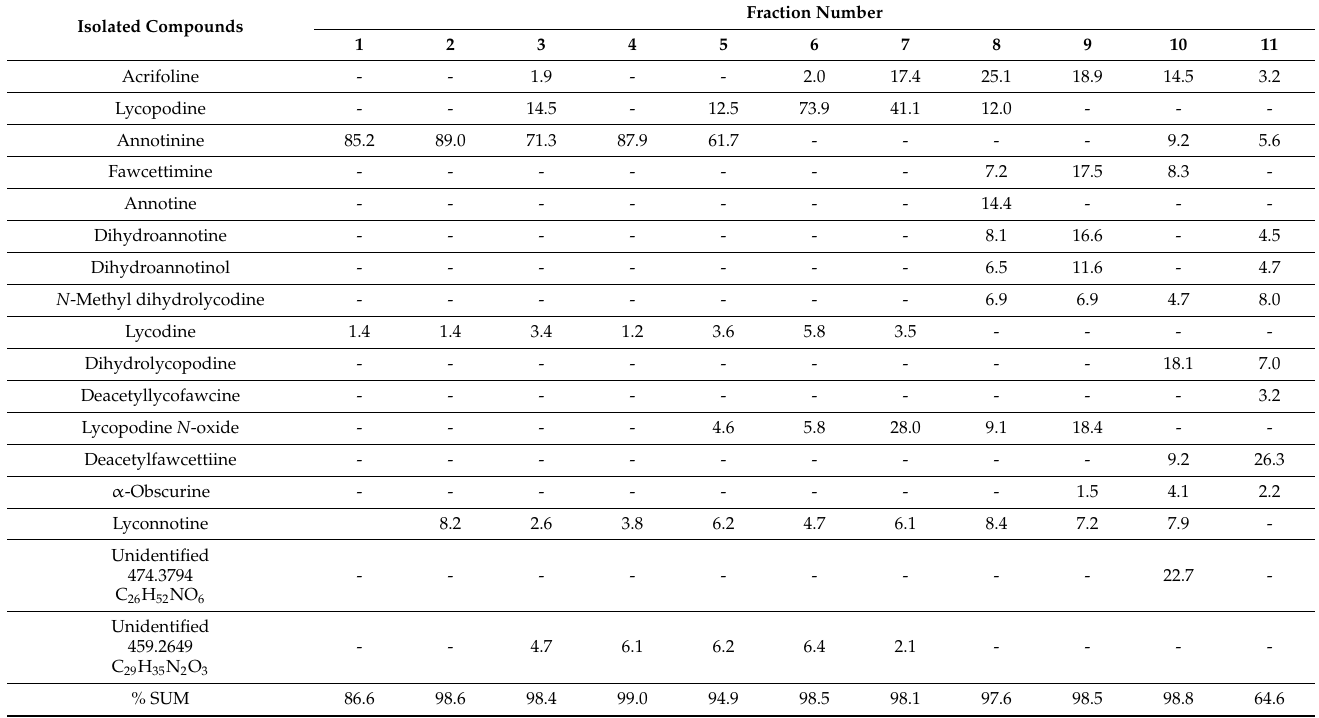
Table 3. Results of alkaloids identified via HPLC/ESI-QTOF-MS present in fractions 1–11 obtained from experiment 2 via VLC using sorbents Al 2 O 3 and silica gel in ratio 3:1 from L. annotinum extract. Isolated